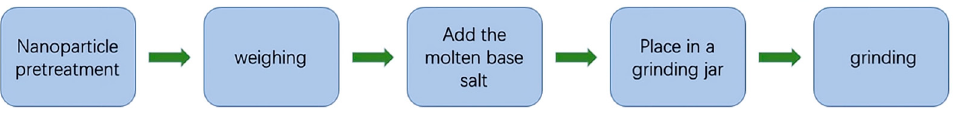
Figure 5. High-energy ball milling method preparation of molten salt nanofluidic